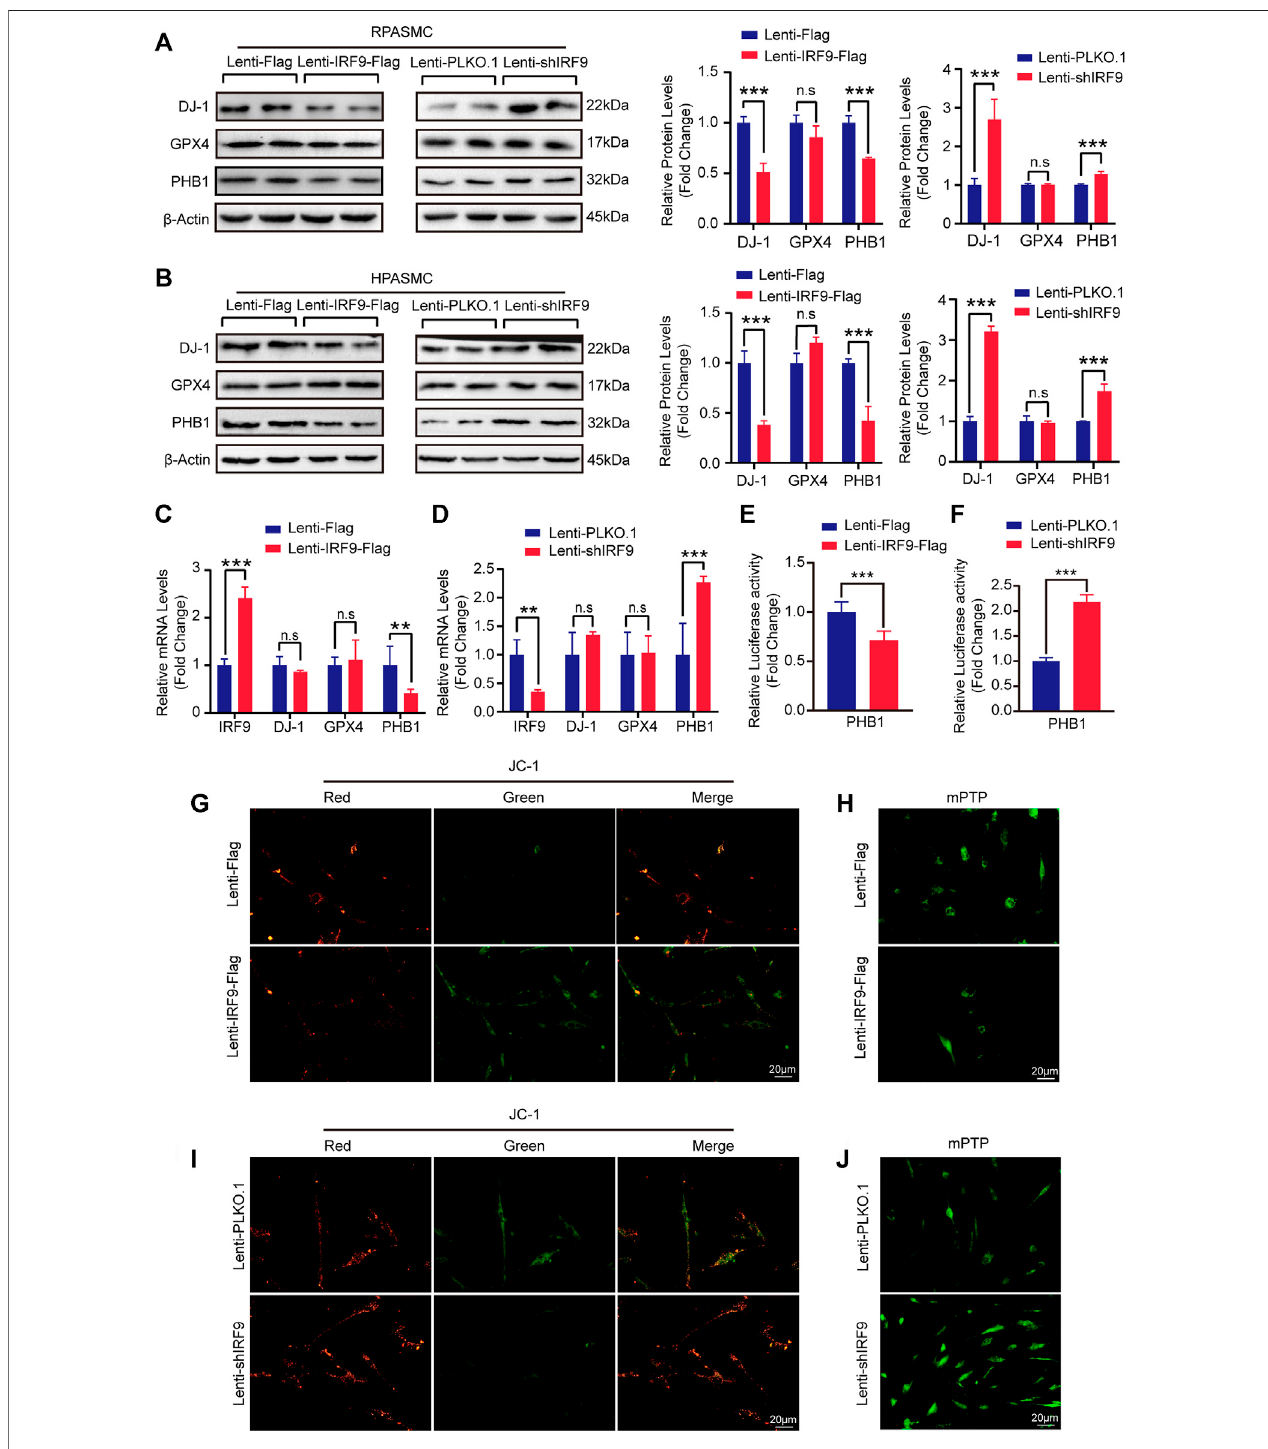
FIGURE 6 | IRF9affects the mitochondrial function through regulatingPHB1expression. (A,B) Theprotein levelsofDJ-1, GPX4 and PHB1in IRF9-overexpressing(Lenti- IRF9-Flag), IRF9-knockdown (Lenti-shIRF9) and neither (Lenti-Flag/Lenti-PLKO.1) RPASMCs (A) and HPASMCs (B) were assessed by western blotting (left panels) under normoxia condition. Proteins levels were quanti fi ed and normalized to β -Actin (right panels) ( n (cid:2) 3 independent experiments). (C,D) The mRNA levels of IRF9, DJ-1, GPX4 and PHB1inHPASMCswith IRF9overexpression (C) or knockdown (D) weredetected byRT-PCR( n (cid:2) 3independentexperiments). (E,F) Theluciferaseactivity controlledby PHB1 promoter was evaluated when IRF9 overexpression (E) or knockdown (F) ( n (cid:2) 6 independent experiments). (G,I) The representative images of mitochondrial membrane potential detected by usingJC-1 kit in HPASMCswith IRF9 overexpression (G) or knockdown (I) under normoxia condition. Scale bar, 20 μ m ( n (cid:2) 3 independent experiments). (H,J) Theopennessofmitochondrialpermeabilitytransitionpore(mPTP)isdetectedbythemPTPkitinHPASMCswithIRF9overexpression (H) orknockdown (J) undernormoxia condition, Scale bar, 20 μ m ( n (cid:2) 3 independent experiments). Values are means ± SD; *** p < 0.001, ** p < 0.01, n.s indicates non signi fi cance.